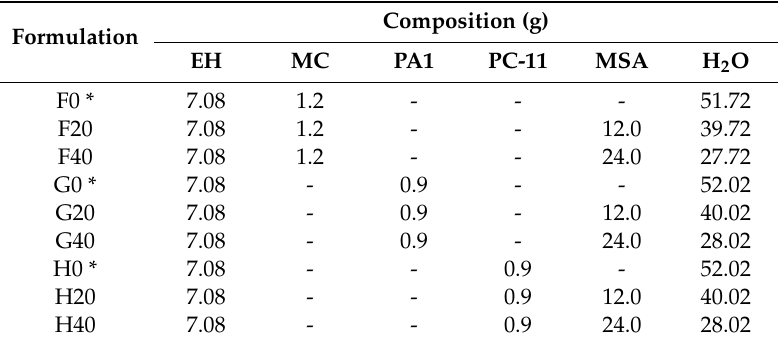
Table 1. The composition of the formulations with Hippocastani seminis extractum spissum (EH): F—MC hydrogels, G—PA1 hydrogels, H—PC-11 hydrogels. Composition (g) Formulation